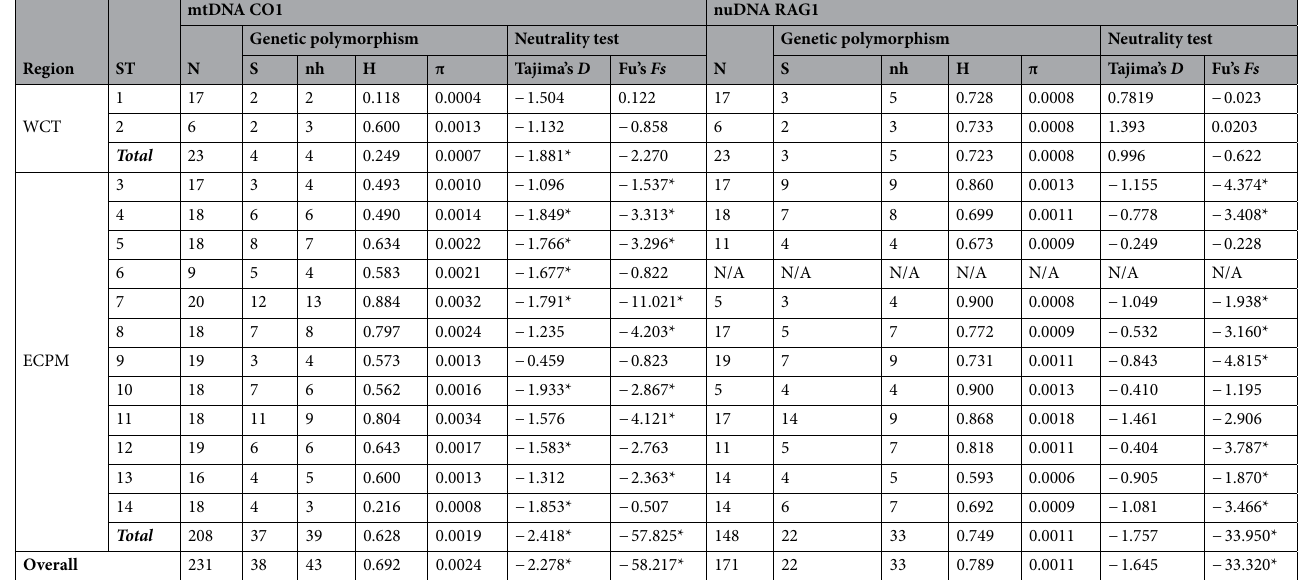
Table 1. Genetic polymorphisms and neutrality tests of Uranoscopus cognatus inferred from the mitochondrial DNA CO1 (534 base pairs) and nuclear DNA RAG1 (1,426 base pairs) sequences. *Significant at P < 0.05. ST sampling station, N sample size, S number of segregating site, nh number of haplotype, H haplotype diversity, π nucleotide diversity, WCT west coast Thailand, ECPM east coast Peninsular Malaysia, N/A data not